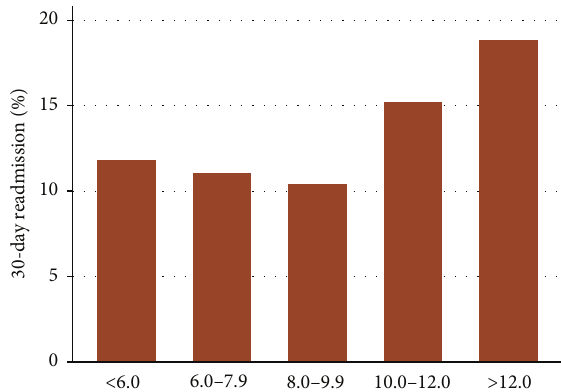
Figure 1: Preoperative White Blood Cell Counts and Risk of 30- day Readmission. The graph plots the risk of all-cause 30-day readmission by five pre-defined categories of preoperative white blood cell counts (in thousands per cubic millimeter, mm 3